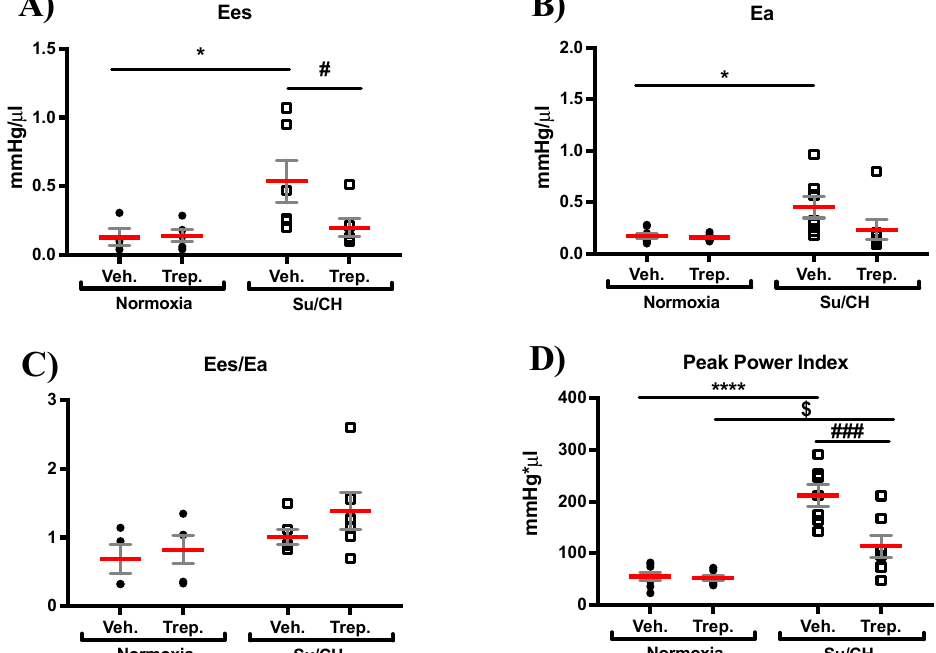
Figure 3. Effect of treprostinil treatment on load-independent RV function. Individual value grouped plots for ( A ) end-systolic elastance (Ees), marker of load-independent contractility, ( B ) ar- terial elastance (Ea), a measure of arterial load, ( C ) Ees/Ea ratio, a marker of RV-PA coupling, and ( D ) peak power index; n = 7–8 animals/experimental group; * and # present significance vs. normoxia+Veh. and SuCH+Veh., respectively; *, # and $ p ≤ 0.05; ### p ≤ 0.001; **** p ≤ 0.0001.